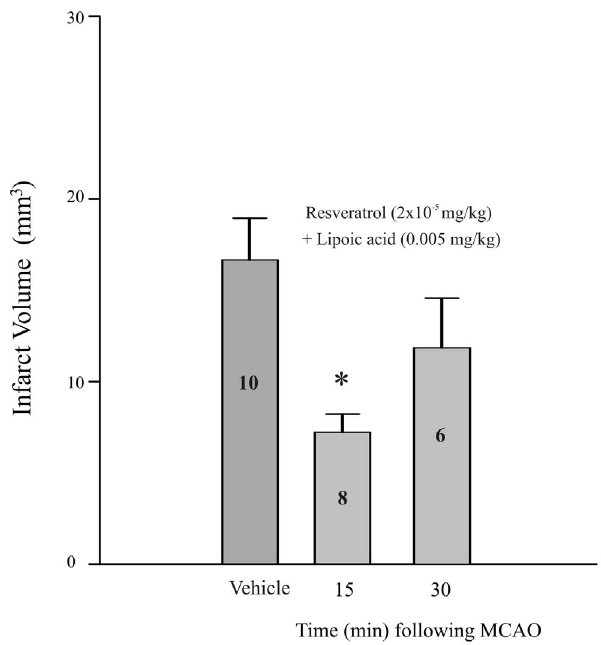
Figure 4. Time course of effect of combining lipoic acid and resveratrol on infarct volume. Bar graph summarizing the effect on infarct volume of administering a non-protective dose of lipoic acid in combination with a protective dose of resveratrol 15 minutes during the occlusion (15 min), or immediately after reperfusion (30 min). Each bar represents the mean 6 S.E.M. (n=5–8/group) and * indicates significance ( p # 0.05) from the vehicle-treated (propylene glycol 4 6 10 2 3% (v/v)) control group.